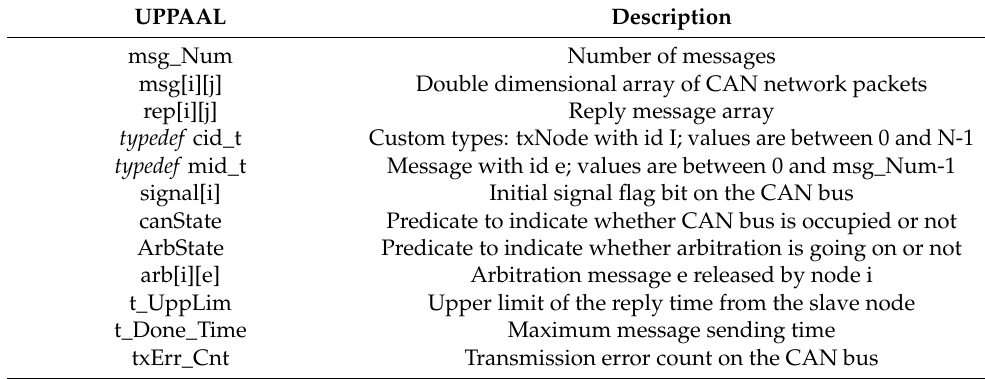
Table 2. Symbol and variable